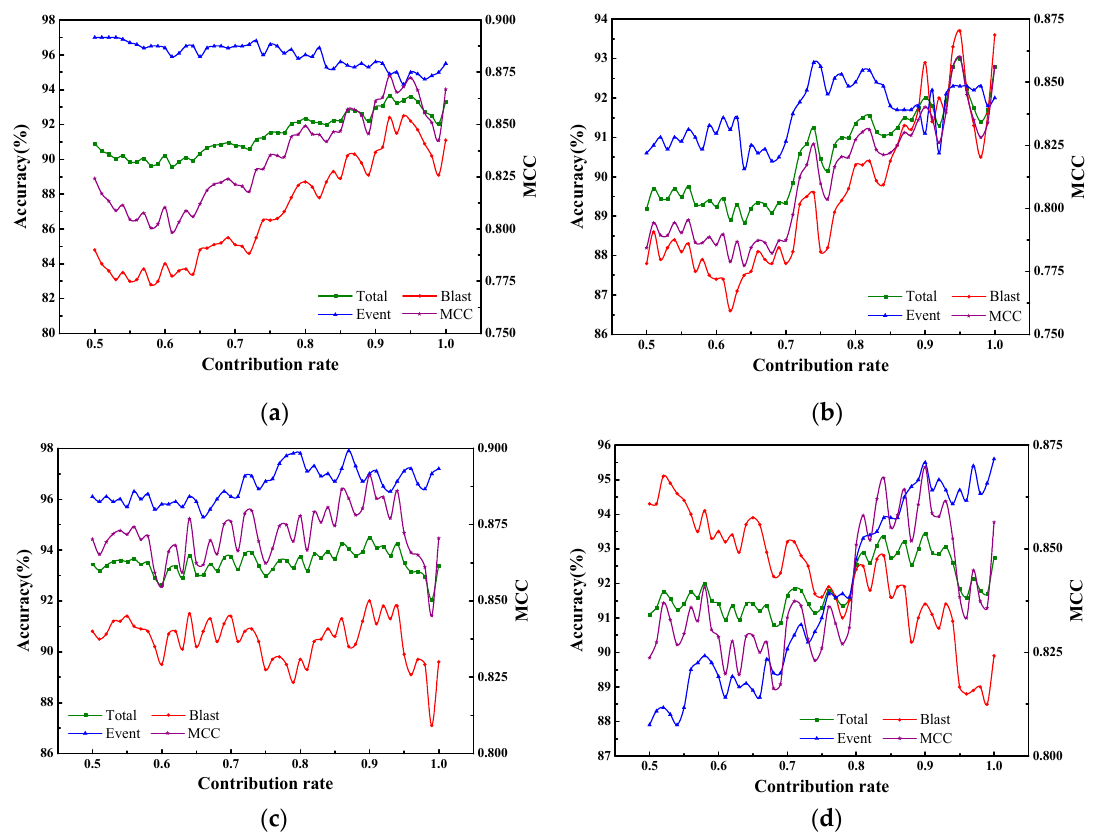
Figure 7. Classification accuracy of micro-seismic events and blasts, total classification accuracy, and quality evaluation parameter MCC for test 1 to test 4 under different contribution rates. ( a ) Test 1; ( b ) Test 2; ( c ) Test 3; ( d ) Test 4. The blue line with triangles, red line with circles, green line with squares, and purple line with stars indicate the classification accuracy of micro-seismic events, classification accuracy of blasts, total accuracy, and MCC, respectively.